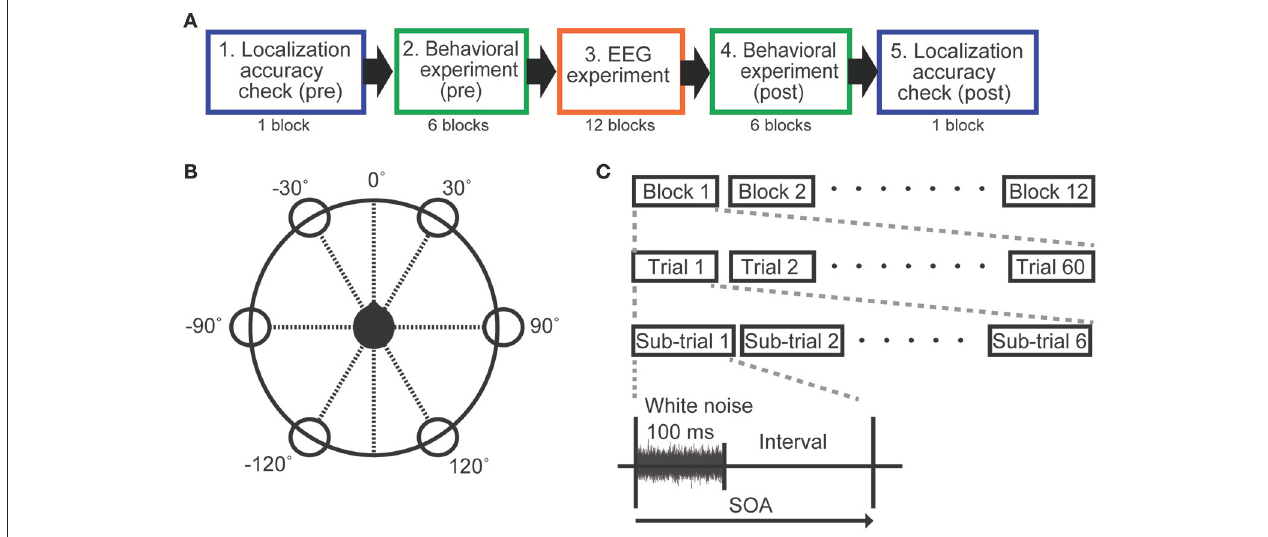
FIGURE 1 | Experimental protocol. (A) Outline of the experiments. (B) The sound image was located in one of six different directions (30 ◦ , − 30 ◦ , 90 ◦ , − 90 ◦ , 150 ◦ , − 150 ◦ ) with 0 ◦ directly facing the user (black head) in the horizontal plane. (C) A sub-trial comprised a 100-ms sound (white noise) and an interval without sound. The SOA was manipulated by changing the interval. Sound duration was fixed at 100ms for all SOA conditions. For each experiment, one of the eight SOAs (200, 300, 400, 500, 600, 700, 800, and 1,100ms) was